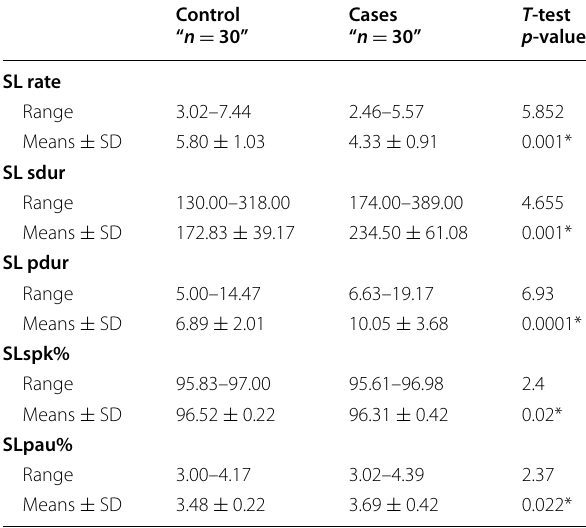
Table 3 Comparison between the two groups regarding generic syllabic